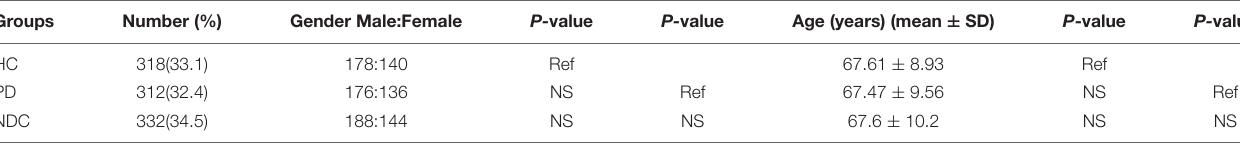
TABLE 1 | Demographic characteristics of subjects enrolled in the present study.